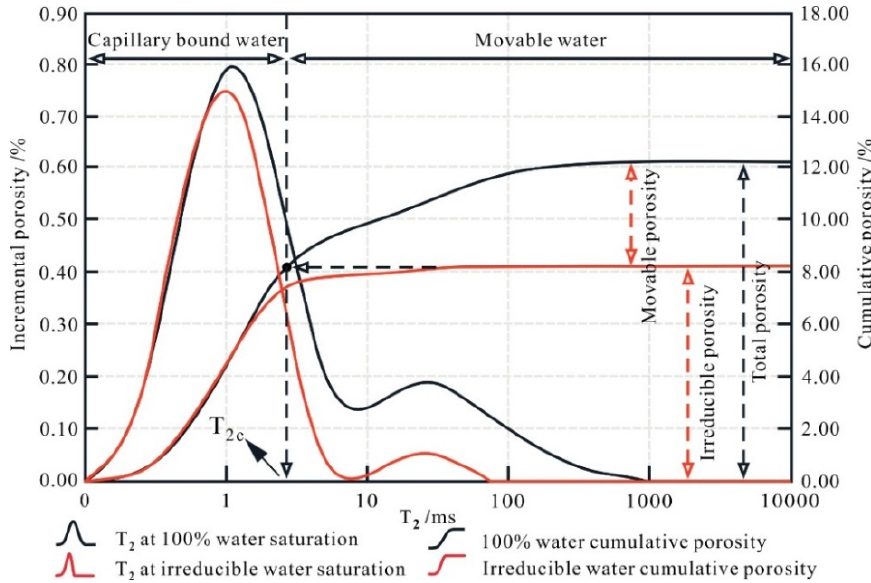
Figure 10. T 2 cuto ff value ( T 2 C ) determined by NMR T 2 spectra at 100% and irreducible water Figure 10. T 2 cutoff value ( T 2 C ) determined by NMR T 2 spectra at 100% and irreducible water saturation.